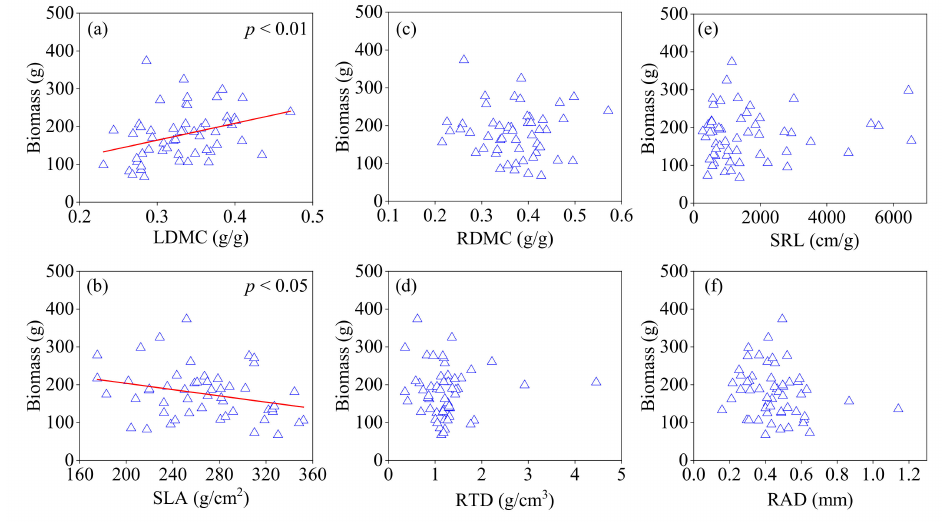
Figure 5. Relationships between aboveground biomass (AGB) and community weighted mean (CWM) trait values ( a – f